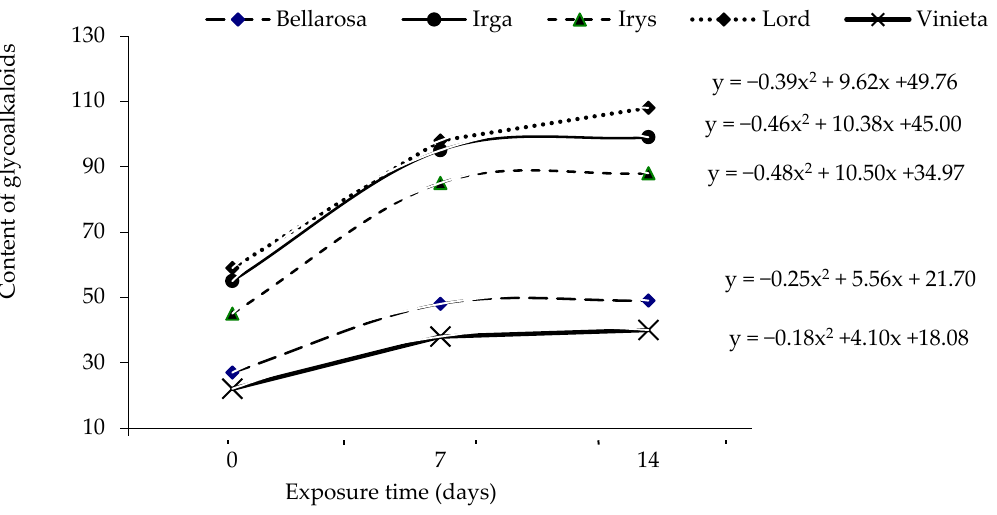
Figure 1. Equations of the relationships between the time of exposure to light and the content of glycoalkaloids in unwashed tubers of the tested varieties (mg · kg − 1 FM).